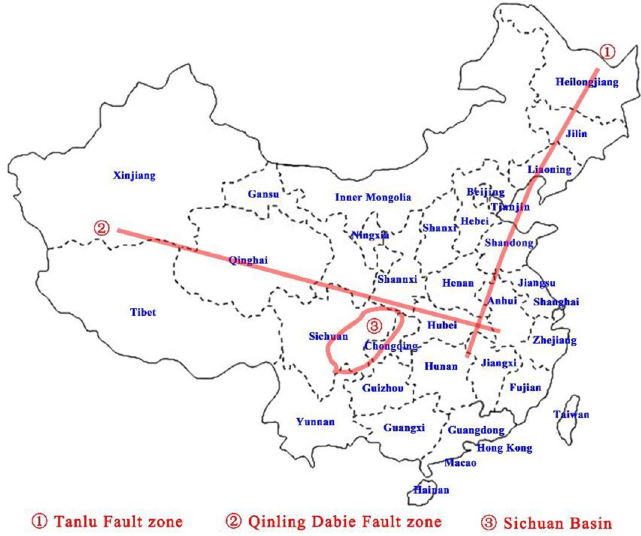
Figure 4. “110” zoning of dynamic coal mine disasters based on the modern tectonic